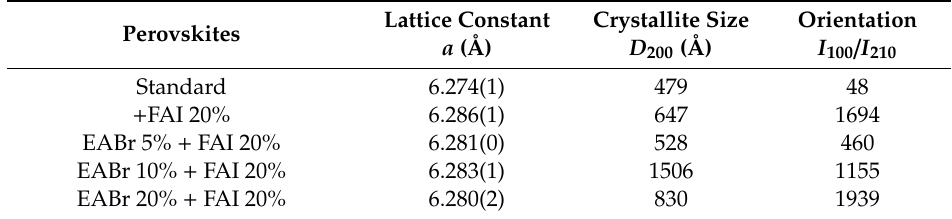
Figure 7. ( a ) X-ray diffraction (XRD) pattern of the present solar cells and ( b ) enlarged pattern of ( a ).